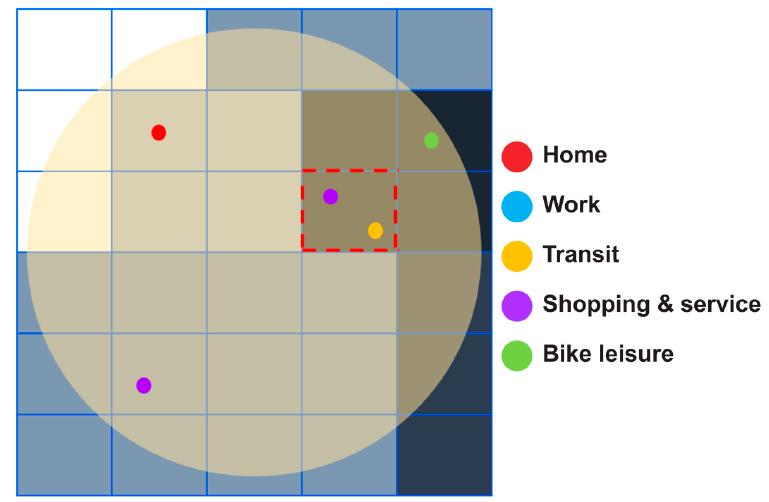
Figure 6. Method for extracting the bike trip purpose using mobile data and POI data.